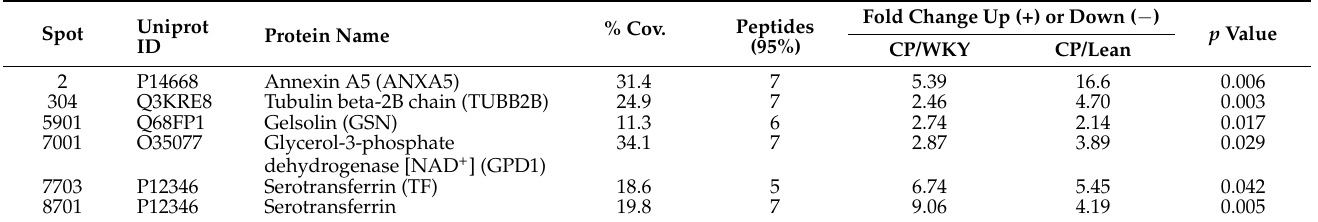
Figure 3. 2D-Oxyblot analysis of epididymal adipose tissues of 25-week-old rats. 2D-oxyblot analy- sis of adipose lysates of representative ( A ) WKY, ( B ) Lean, and ( C ) CP. Proteins (100 µg) were treated with DNPH and separated by 2DE, then transferred onto a PVDF membrane. The membrane was incubated with anti-DNP primary antibody, followed by incubation with horseradish peroxidase- conjugated secondary antibody. Reaction was visualized with ECL. The obtained images were pro- cessed using PDQuest to match spots and provide spot volumes. ( D ) Blue circles: the corresponding carbonylated spots on the 2D-DIGE.